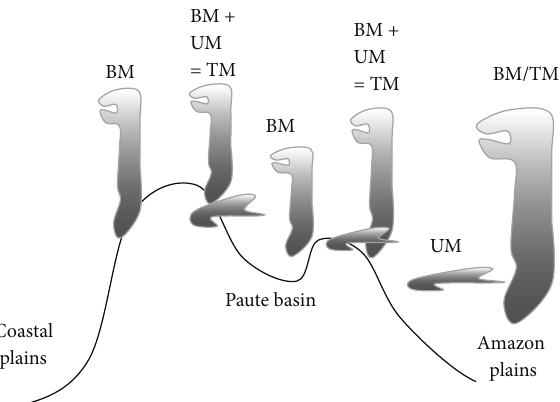
Figure 7: Profile of elevation and Pearson correlation of CF with UM, BM, and TM normalized observational precipitation regimens. (For the location of the profile line refer to Figure 1.)